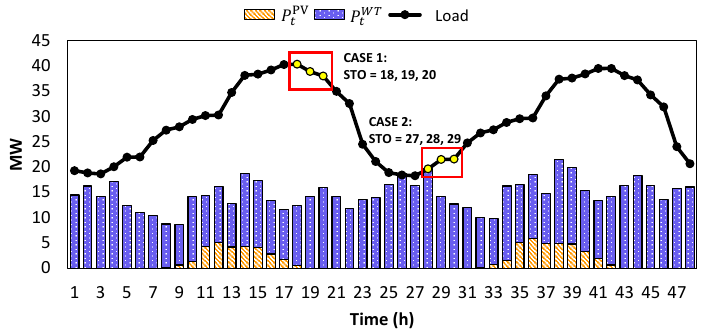
Figure 5. Forecasted renewable generation and load.